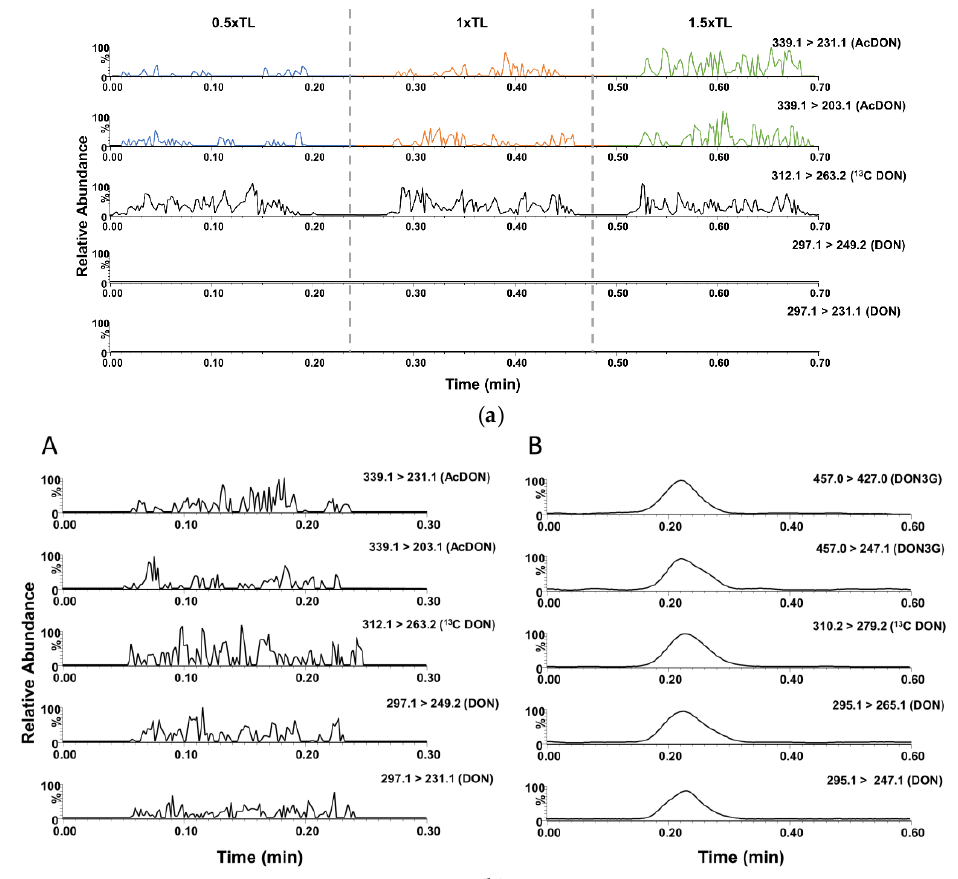
Figure 6. ( a ). Chronogram of AcDON-spiked wheat sample used to develop the ID-LFIA and retrieved in dissociation solution analyzed by DART-QqQ-MS/MS, demonstrating the three distinct TL in blue 0.5× TL, orange 1× TL, and green 1.5× TL. 13 C 15 DON is added as an internal standard before the MS analysis. ( b ). Chronogram of the incurred corn starch sample used to develop the ID-LFIA and retrieved in dissociation solution analyzed in A . (+)DART-QqQ-MS/MS and B . ( − )ESI-QqQ-MS/MS in flow injection analysis mode. 13 C 15 DON is added as an internal standard prior to MS analysis. Table 3. Results from ID-LFIA/DART-QqQ-MS/MS analysis and the respective LFIA smartphone screening of AcDON- spiked wheat samples at three target levels and the analysis of an incurred corn starch sample. ID-LFIA/DART-QqQ-MS/MS LFIA Smartphone TL